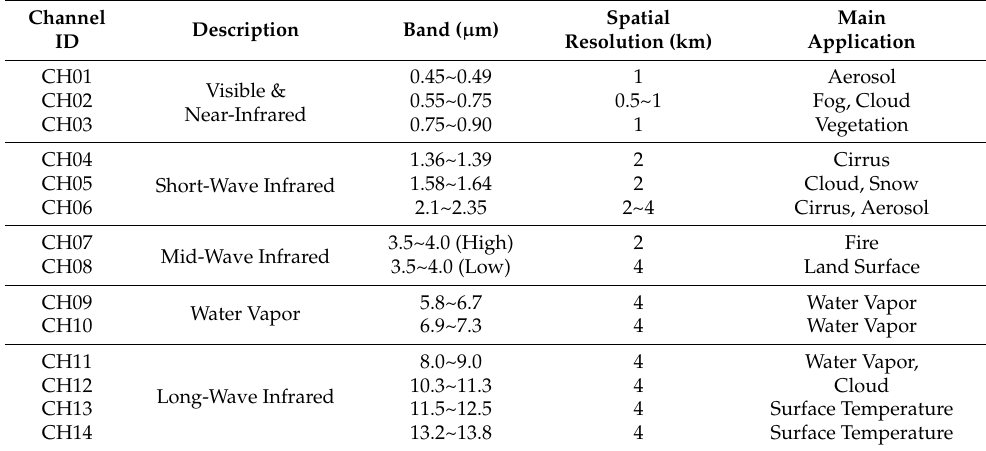
Table 1. The description of spectral image information.